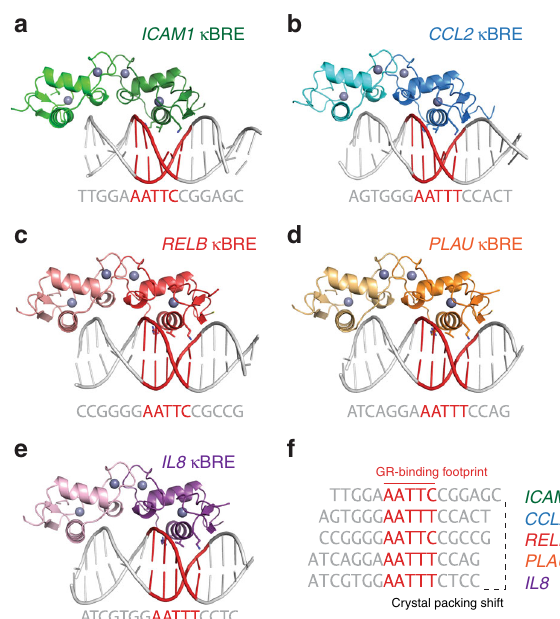
Fig. 3 Five crystal structures of the GR DBD bound to NF- κ B response elements reveal its binding footprint. a – e Overall representations of fi ve GR DBD – NF- κ B response element crystal structures. In each case, the GR DBD crystallized as a dimer in the asymmetric unit, with one monomer positioned over a DNA end stacking junction. The DNA sequence is shown below each structure, with the GR-binding footprint in red. f The DNA- binding footprints of GR are aligned, showing that crystal packing shifts in order to accommodate binding of GR to a speci fi c AATTY sequence